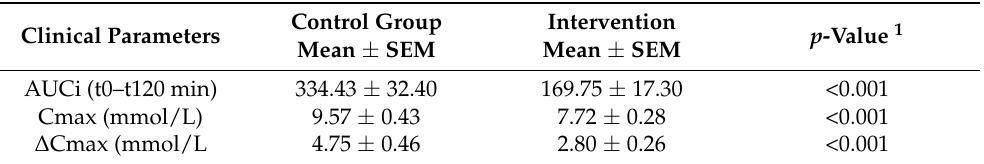
Table 4. Blood glucose incremental area under the curve (AUCi), blood glucose maximum concen- tration (Cmax), and variation of blood glucose maximum concentration ( ∆ Cmax) mean values in control and intervention groups (n = 12, each